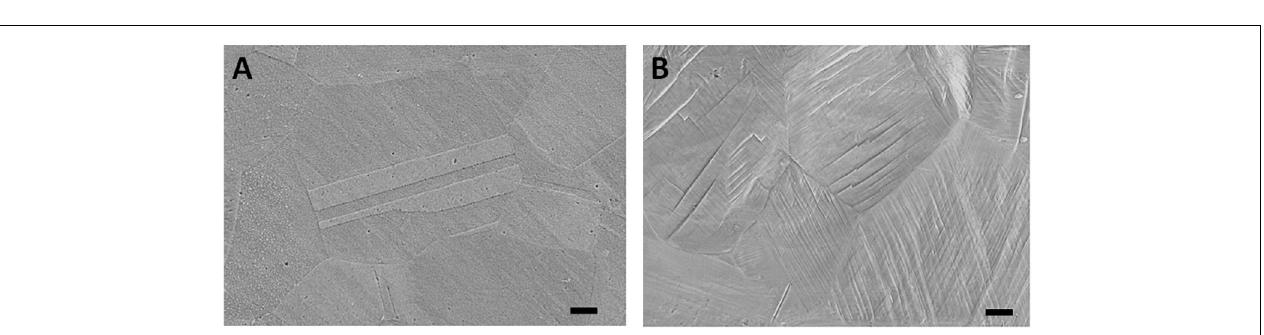
FIGURE 2 | Scanning electron microscopy images of the (A) undeformed and (B) 25% deformed samples. Scale bars are 3 µ m. (Figure is more readable and visible on the screen rather than in print).